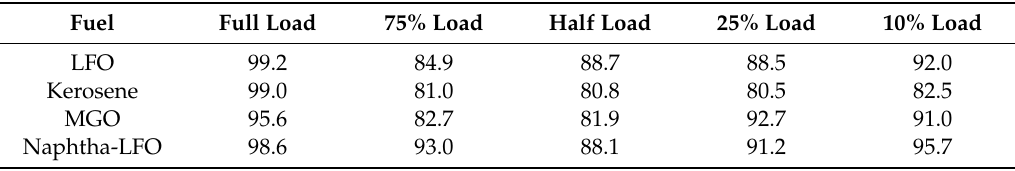
Table 4. Shares of the particles detected above the size category of 23 nm.